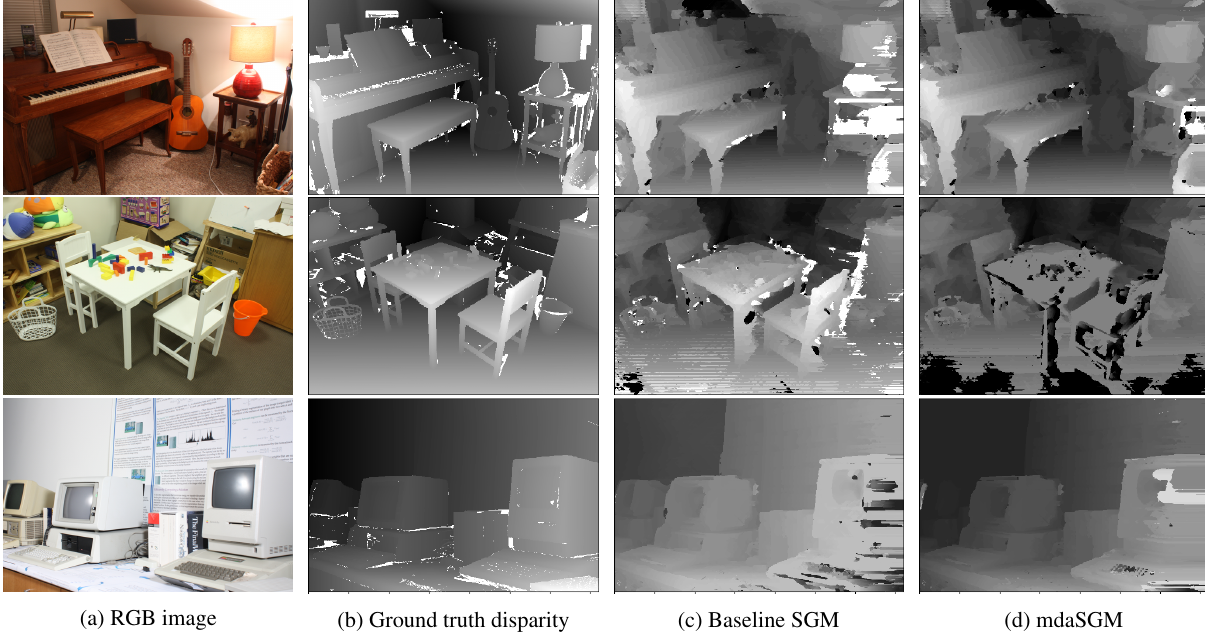
Figure 12. Qualitative results of mdaSGM on different samples (from top to bottom: Piano, Playroom, Vintage) from the Middlebury 2014 Stereo dataset (Scharstein et al., 2014) showing ground-truth disparity maps (b) and disparity maps derived from the baseline SGM (c) and mdaSGM (d), respectively. The method of (Liu et al., 2015) was used for mono-depth predictions in